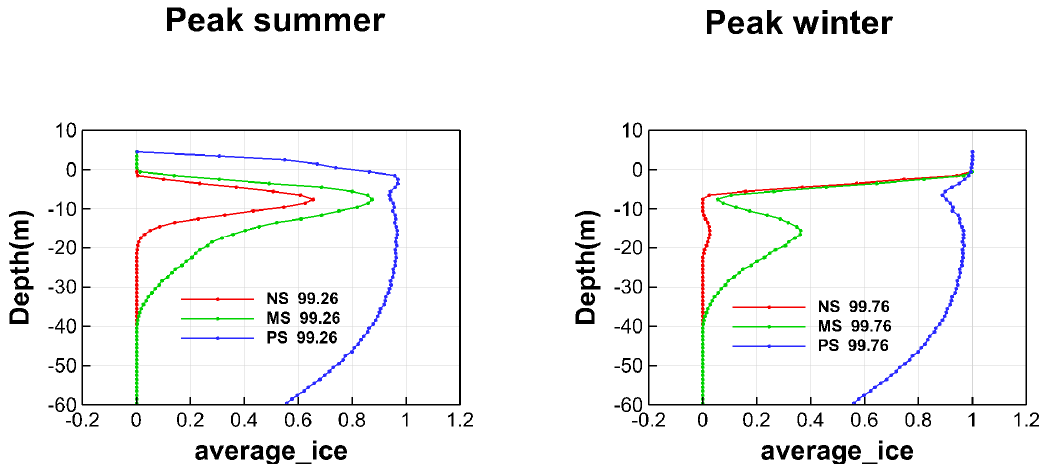
Figure 1. Lateral average ice content as a function of depth under stable average surface temperatures ( − 1 °C, no warming) for the simulation cases of no soil (NS), mineral soil (MS), and peat soil (PS) in peak summer ( left ) and peak winter ( right ).